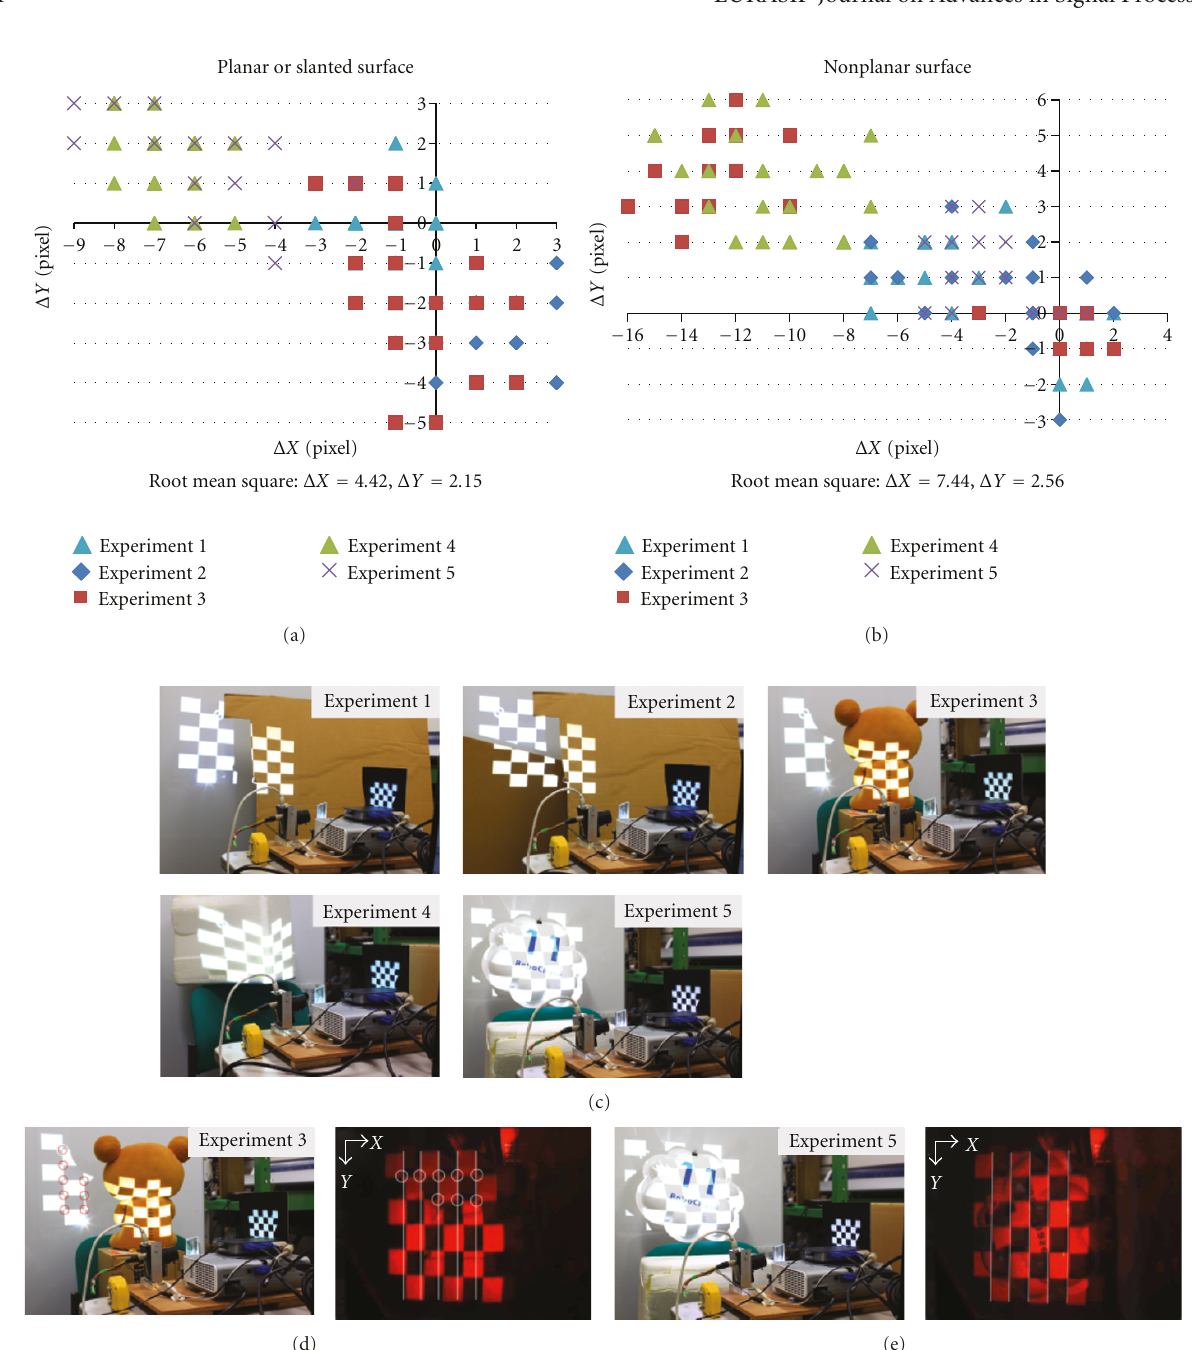
of the calibration. This is shown in Figure 13(d) where there are two groups of tested points: 8 and 17 points with and without bounding circles, respectively. The first group of points lying on the whiteboard has small geometric errors whereas the second group of points projected onto the doll in front of the whiteboard provides larger geometric